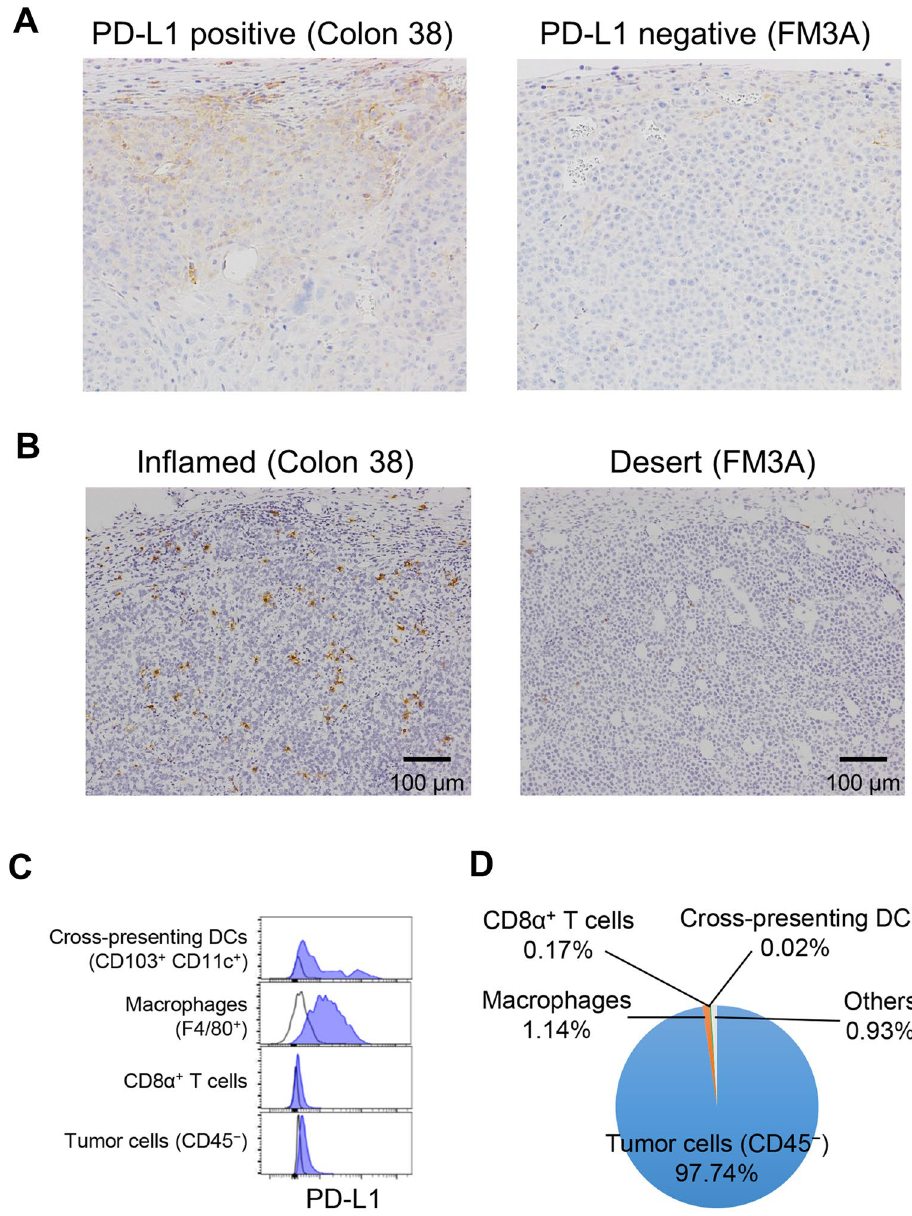
Figure 2. PD-L1 expression and CD8α + infiltration in FM3A tumor model. ( A ) PD-L1 immunohistochemical staining in tumor tissue at baseline in the Colon 38 model (positive control) and FM3A model. ( B ) CD8α immunohistochemical staining in tumor tissue at baseline. ( C ) PD-L1 expression on tumor-infiltrating immune cells and tumor cells in FM3A tumors. ( D ) Distribution of cells in FM3A tumors. Cells were determined by flow cytometric